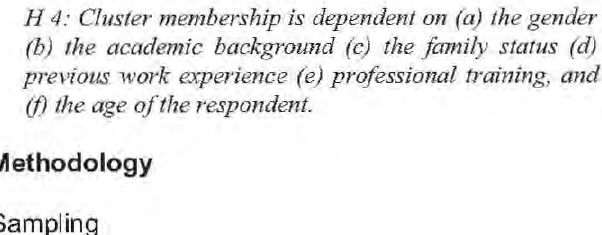
Table 1: Attributes and levels used for conjoint survey